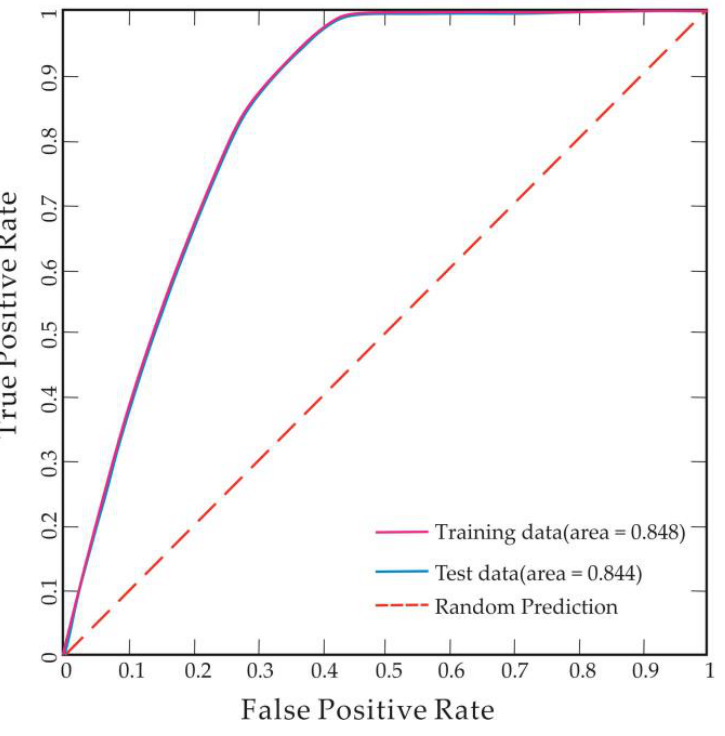
Figure 18. ROC curve of MaxEnt model.